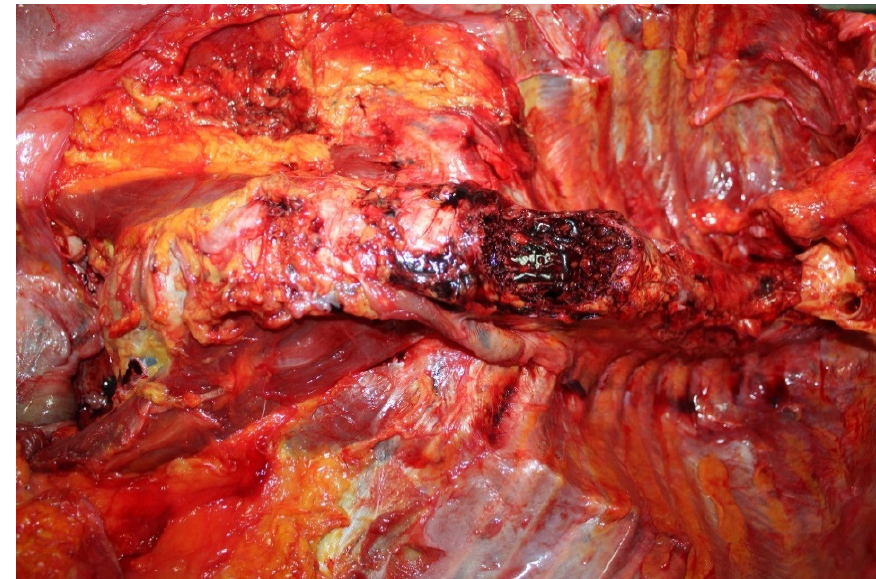
Figure 3. Vertebral fractures (T11 ‐ T12) at autopsy in case 1.